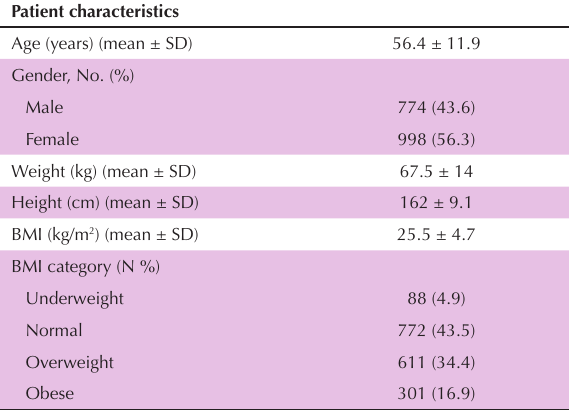
Table 1. General characteristics of patients with MINOCA Patient